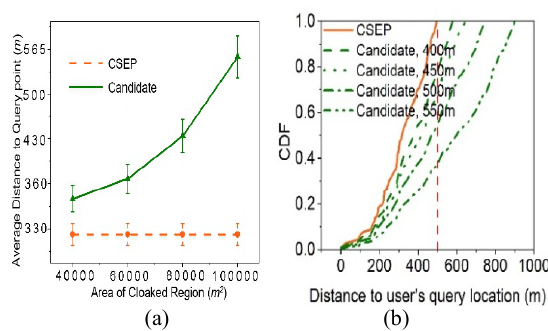
Fig. 4. Comparison between CSEP results and candidate results.(a) Average distance to query location; (b) CDF of